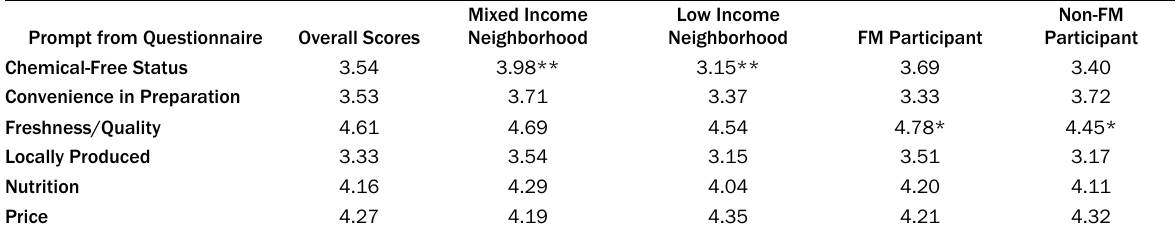
Table 2. Comparison of Food Values (1-5 Likert scale: 1=not a priority, 2=low priority, 3=neutral, 4=moderate priority, 5=high priority)